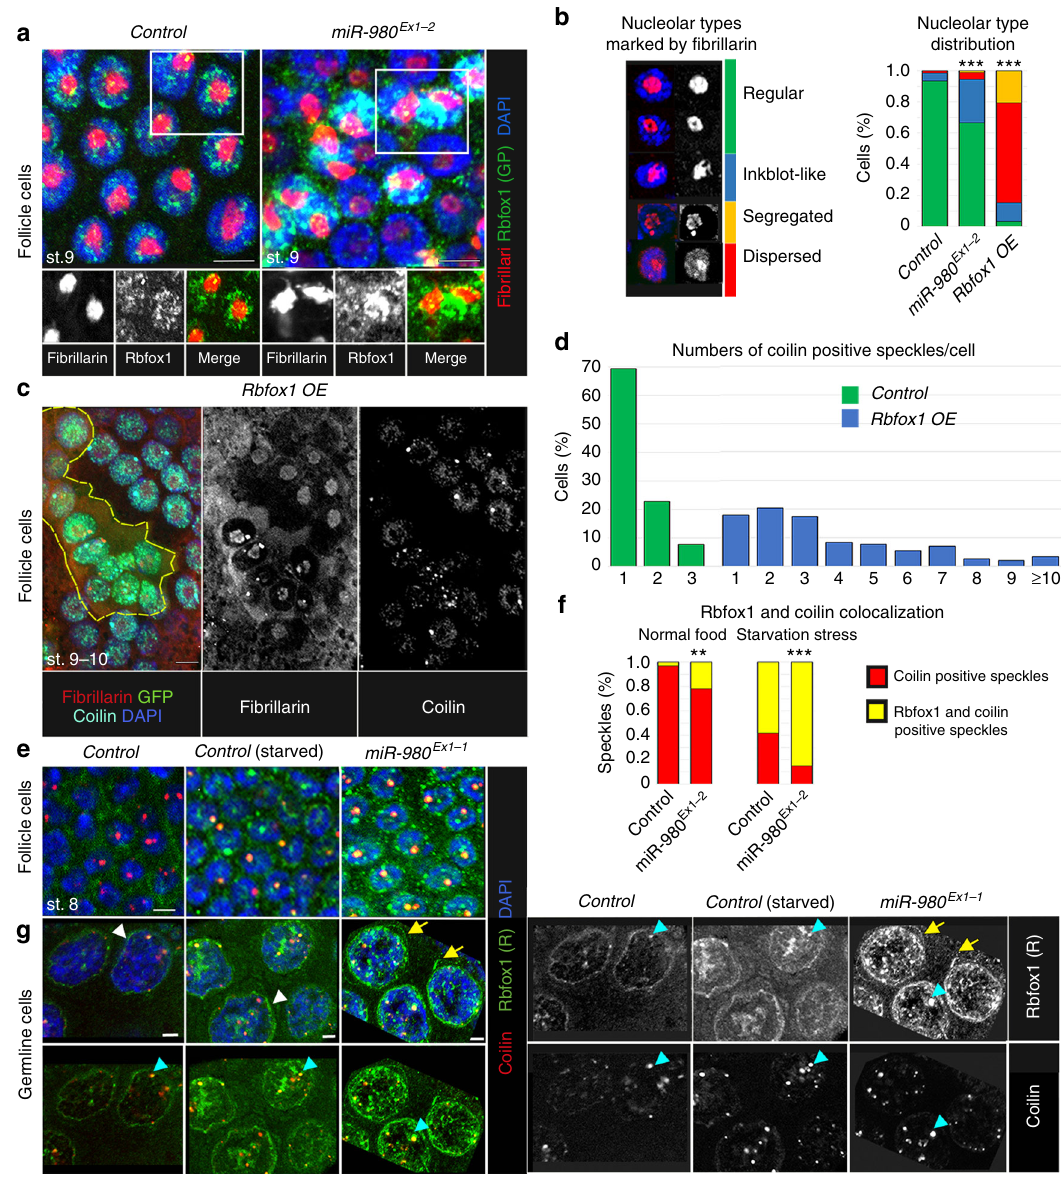
Fig. 5 Rbfox1 colocalizes with membraneless nuclear organelles associated with RNA metabolism. a In follicle cell nuclei, Rbfox1 is associated with chromatin and enriched in the granular component of the nucleolus. Rbfox1 upregulation in miR-980 mutants modi fi es nucleolar shape and size. b Quanti fi cations of nucleolar type distribution in st.9-10 follicular epithelial cells ( n = 273 cells for Control , 234 for miR-980 Ex1-2 and 92 for Rbfox1 OE ). c Increased Rbfox1 expression modi fi es nucleolar shape and size and CB size and numbers. Rbfox1-overexpressing clone is outlined by yellow line ( hsFlp; UAS-Rbfox1/ + ; act > CD2 > Gal4 UAS-GFP ). d Most of the st.9-10 follicle cells contain one CB, while Rbfox1-overexpressing cells have 1 to > 10 smaller CBs per cell ( n = 199 and 156 cells, respectively). e Rbfox1 association with CBs is enhanced by miR-980 loss and stress. f Percentages of Rbfox1-positive CBs are signi fi cantly increased in miR-980 mutants in comparison to Control ( n = 82 and 256 CBs, respectively). This tendency becomes even more pronounced upon starvation stress ( n = 598 and 262 CBs for miR-980 and Control , respectively). g In the germline, Rbfox1 colocalizes with CBs (blue arrowheads) and this colocalization is enhanced by miR-980 loss and stress. Rbfox1 can be also detected in the nuage of the germline nurse cells (white arrowheads). In starved miR-980 mutants, Rbfox1-positive fi bers can be observed (yellow arrows, right panel). Rbfox1 (green); DAPI (blue); Fibrillarin (nucleolus, red, a – c ); Coilin (CB, cyan, c , red, e , g ). Follicular epithelial cells ( a – c , e ), germline nurse cells ( f ). Images in a , b , e – g - single Z-sections, c - maximum intensity projection of multiple Z-sections. Scale bars 5 µ m. Two-Way Tables and Chi-square test were applied for statistics in b and f , ***p ≤